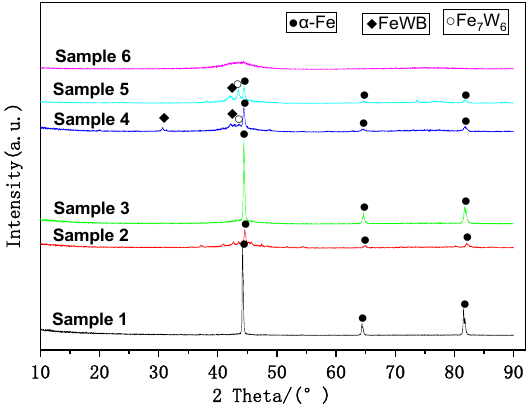
Figure 3. XRD patterns of atomized powder with different compositions at room temperature.